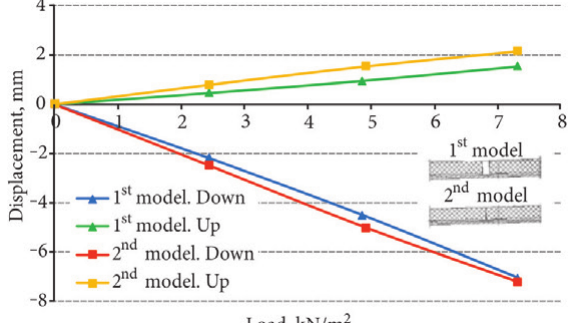
Fig. 9. Displacements under unsymmetrical load